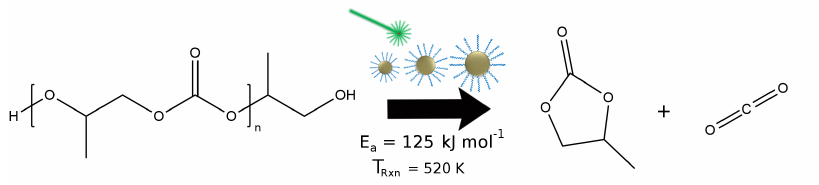
Figure 1. Decomposition reaction for poly(propylene